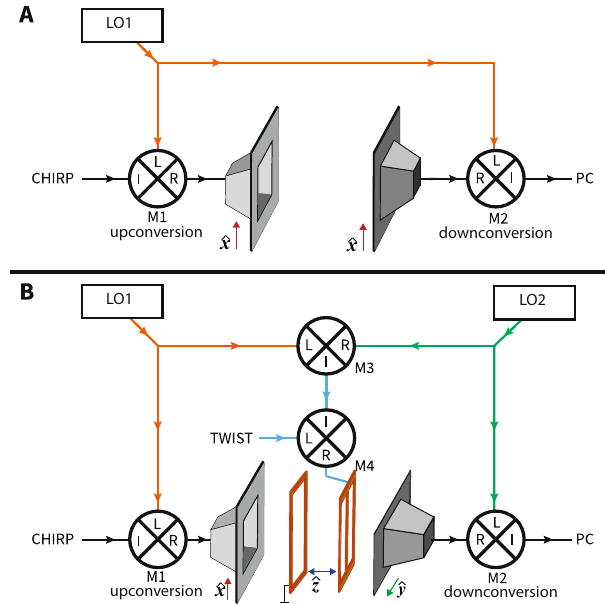
Fig. 5 Comparison of microwave circuit design. A Schematic of the standard microwave circuit for microwave spectroscopy. B Schematic of the new circuit design for acquiring three-wave mixing spectra. The twist electrodes have been added for clarity. The upconversion and downconversion step are done with different local oscillators LO1 and LO2. Their beat note, 2 KHz in this work, is mixed with the twist to eliminate all non-M3WM